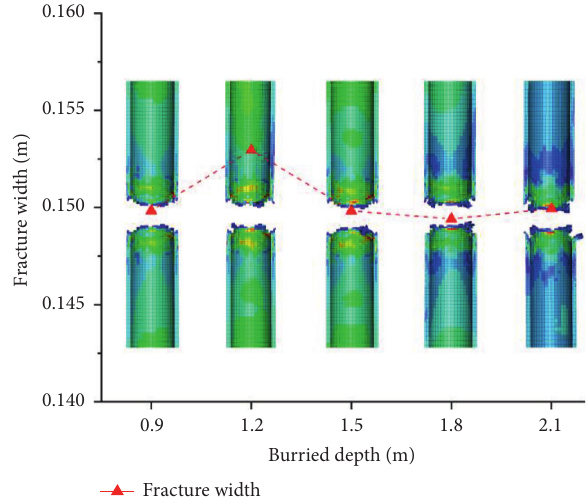
Figure 17: Fracture width of pipes under different buried